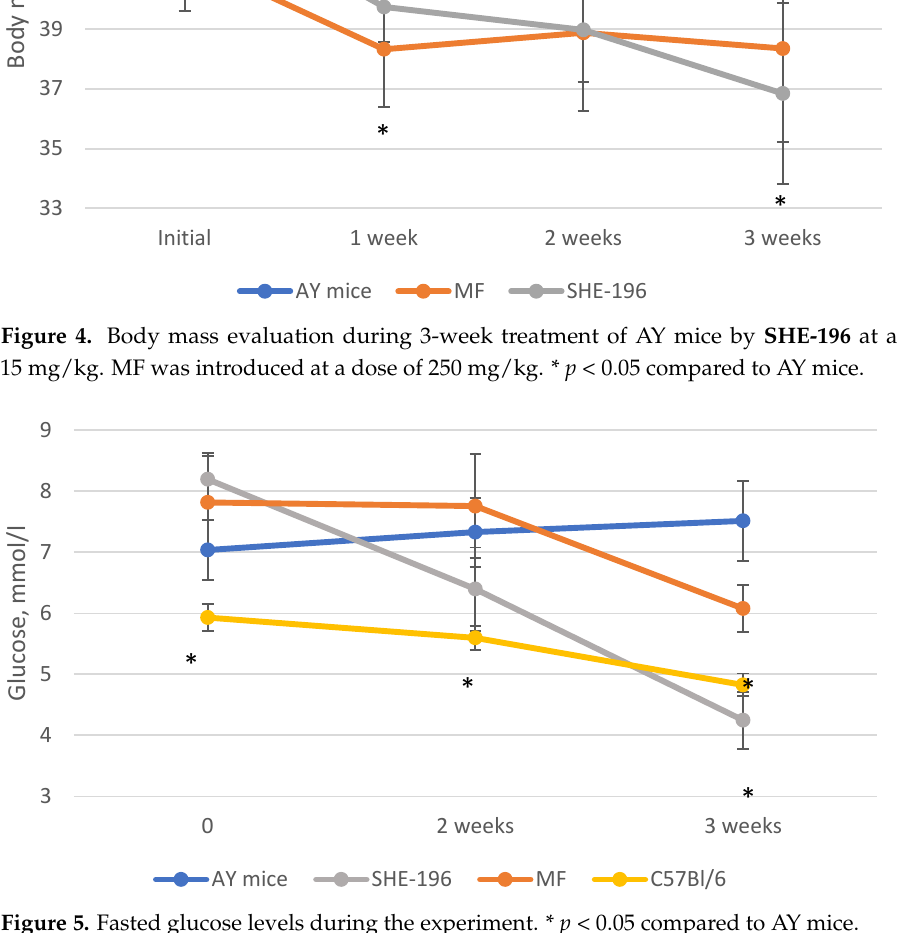
Figure 5. Fasted glucose levels during the experiment. * p < 0.05 compared to AY mice.